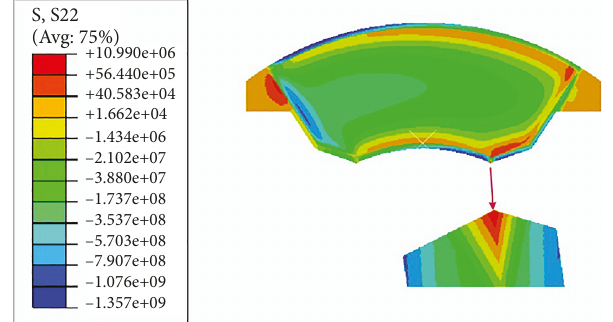
Figure 7: Circumferential stress across disc thickness.